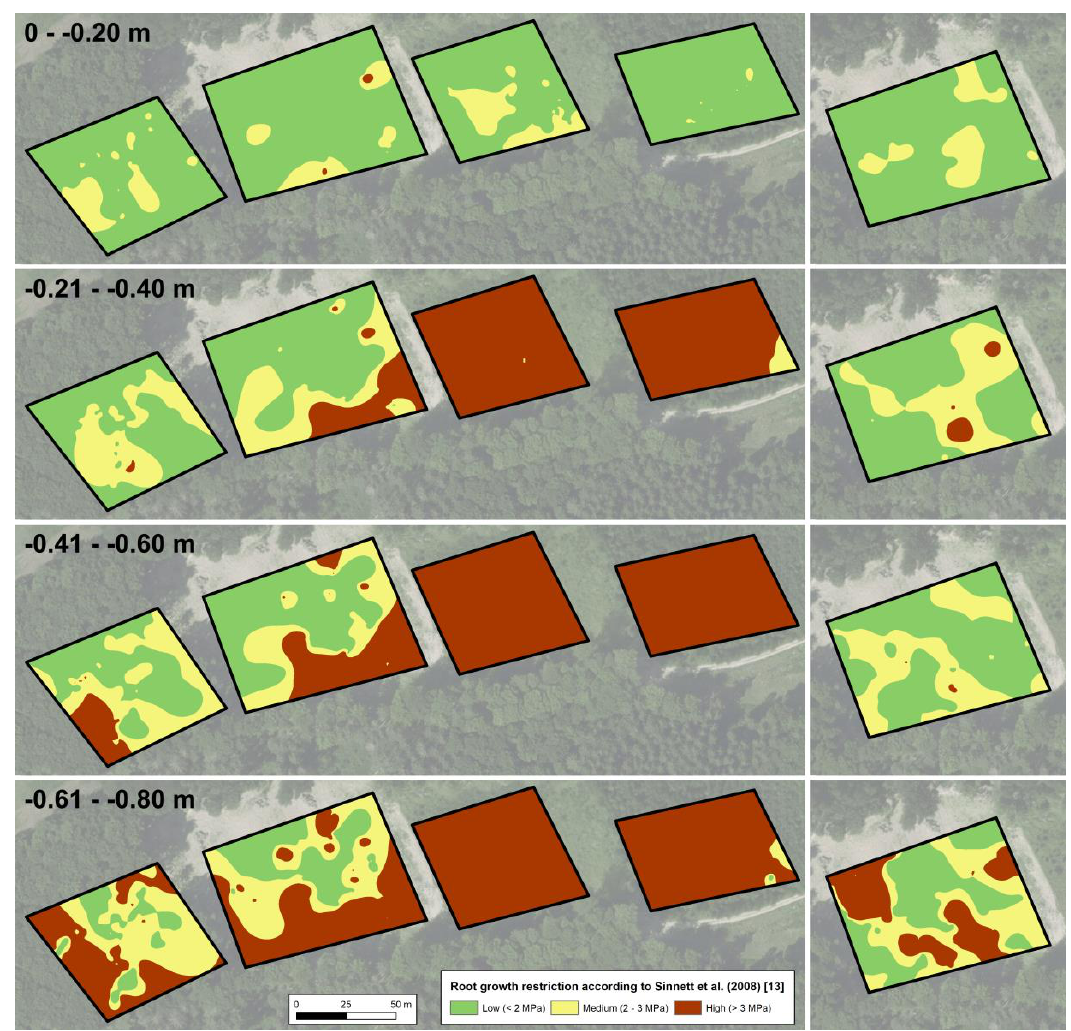
Figure 19. Interpolated penetration resistance, root growth restriction classes according to [13]. Right column: Area CUT EX.